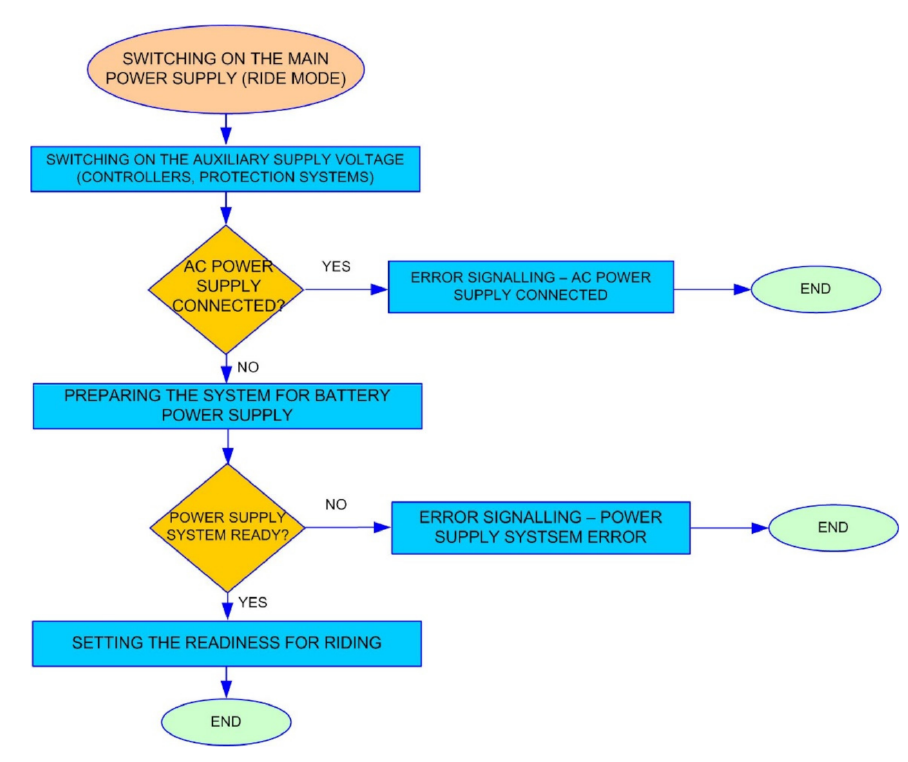
Figure 6. Algorithm for the procedure of switching on the supply voltage in the ride mode. The algorithm controlling the process of switching on the voltage in the operating mode has been shown in Figure 7. In the operating mode, after switching on the auxiliary voltage, the converters (P1, P2, and P3) are configured for work. While the machine is in operation (dr illing, bolting), the mine’s AC network is used as a power source. As in the case of machine rides, the power system is first prepared, and its correct operation is checked. In the next step, the battery is connected, and the P1 and P3 converters are connected to the circuit. The electrical system is now ready for